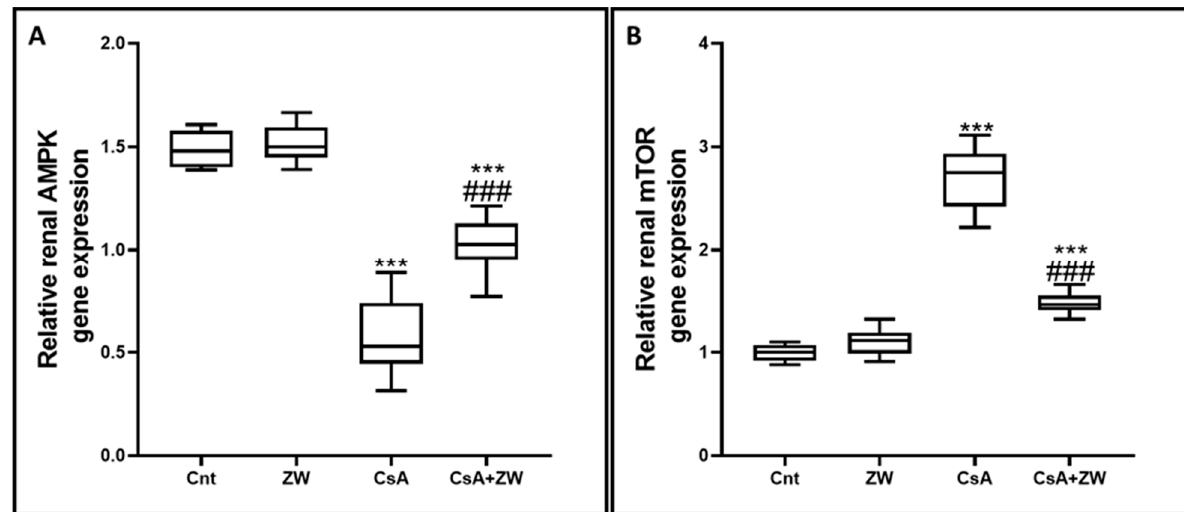
Figure 12. The e ff ect of ZW treatment on the expression of the (A) AMPK and (B) mTOR genes in various groups. *** p < Figure 12. The effect of ZW treatment on the expression of the ( A ) AMPK and ( B ) mTOR genes in 0.001 vs. control ; ### p < 0.001 vs. CsA. various groups. *** p < 0.001 vs. control ; ### p < 0.001 vs.